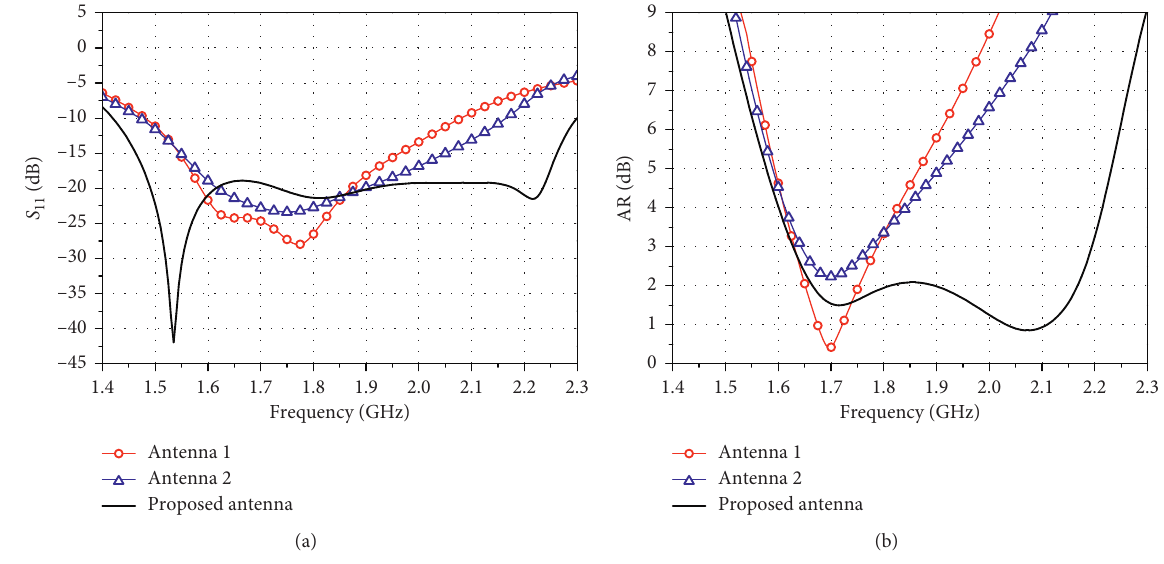
Figure 3: Simulated results of the three CP antennas. (a) S